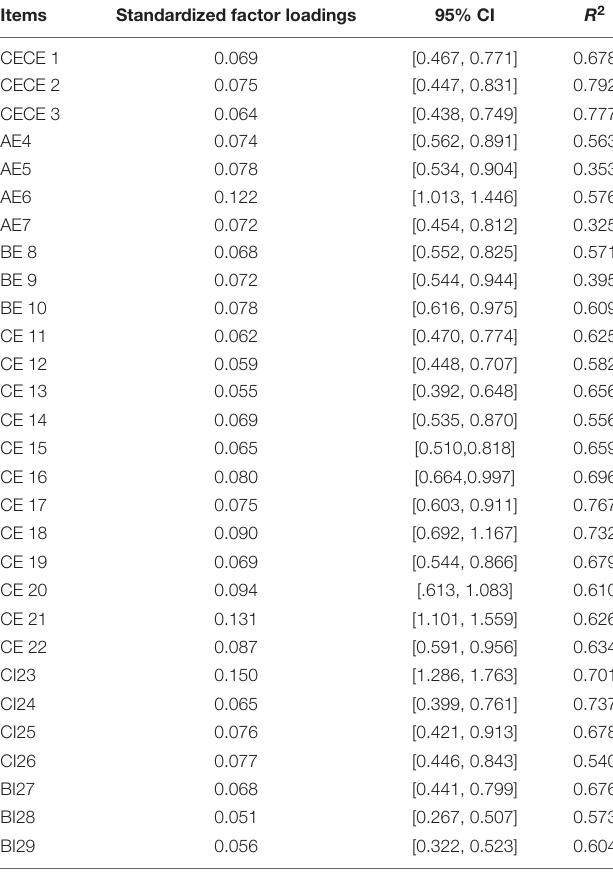
TABLE 5 | Confirmatory factor analysis.